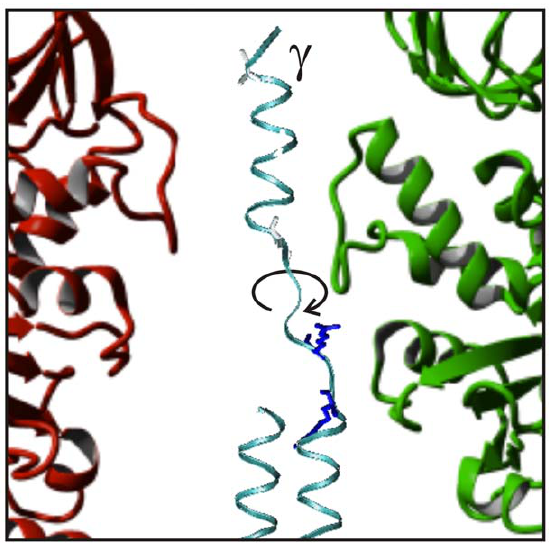
Figure 5. Still picture of a molecular dynamics simulation of unwinding subunit c . The calculation by D. Cherepanov was performed as described in Gumbiowski et al. [17]. In short a torque of 56 pNnm was applied to the last 30 residues of subunit c (MM10), which was fixed at residue c 285C. The calculation was done by NAMD2 [32] and CHARMM22 [33]. The picture shows the uncoiled C-terminal end of subunit c within the same hydrophobic bearing of subunits a and b as in Fig.